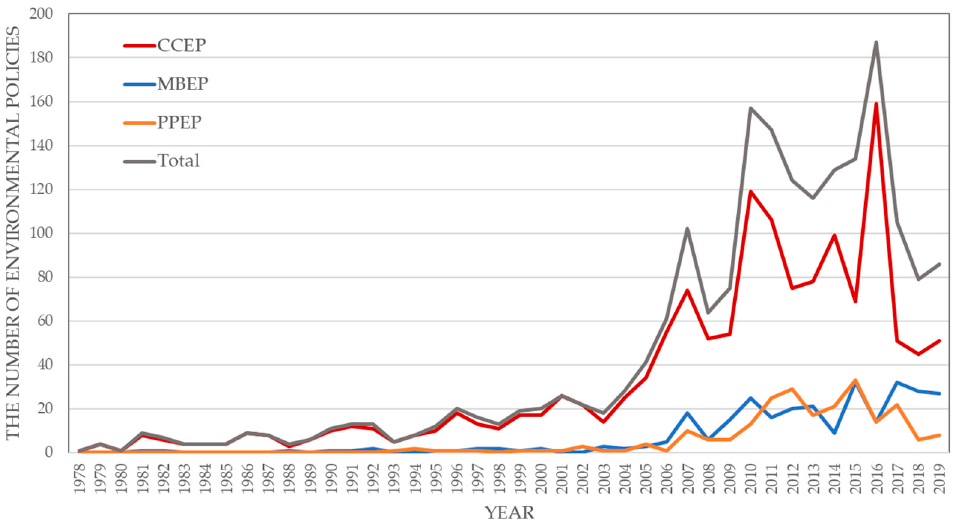
Figure 3. Environmental policy number in China during 1978 to 2019 [37].